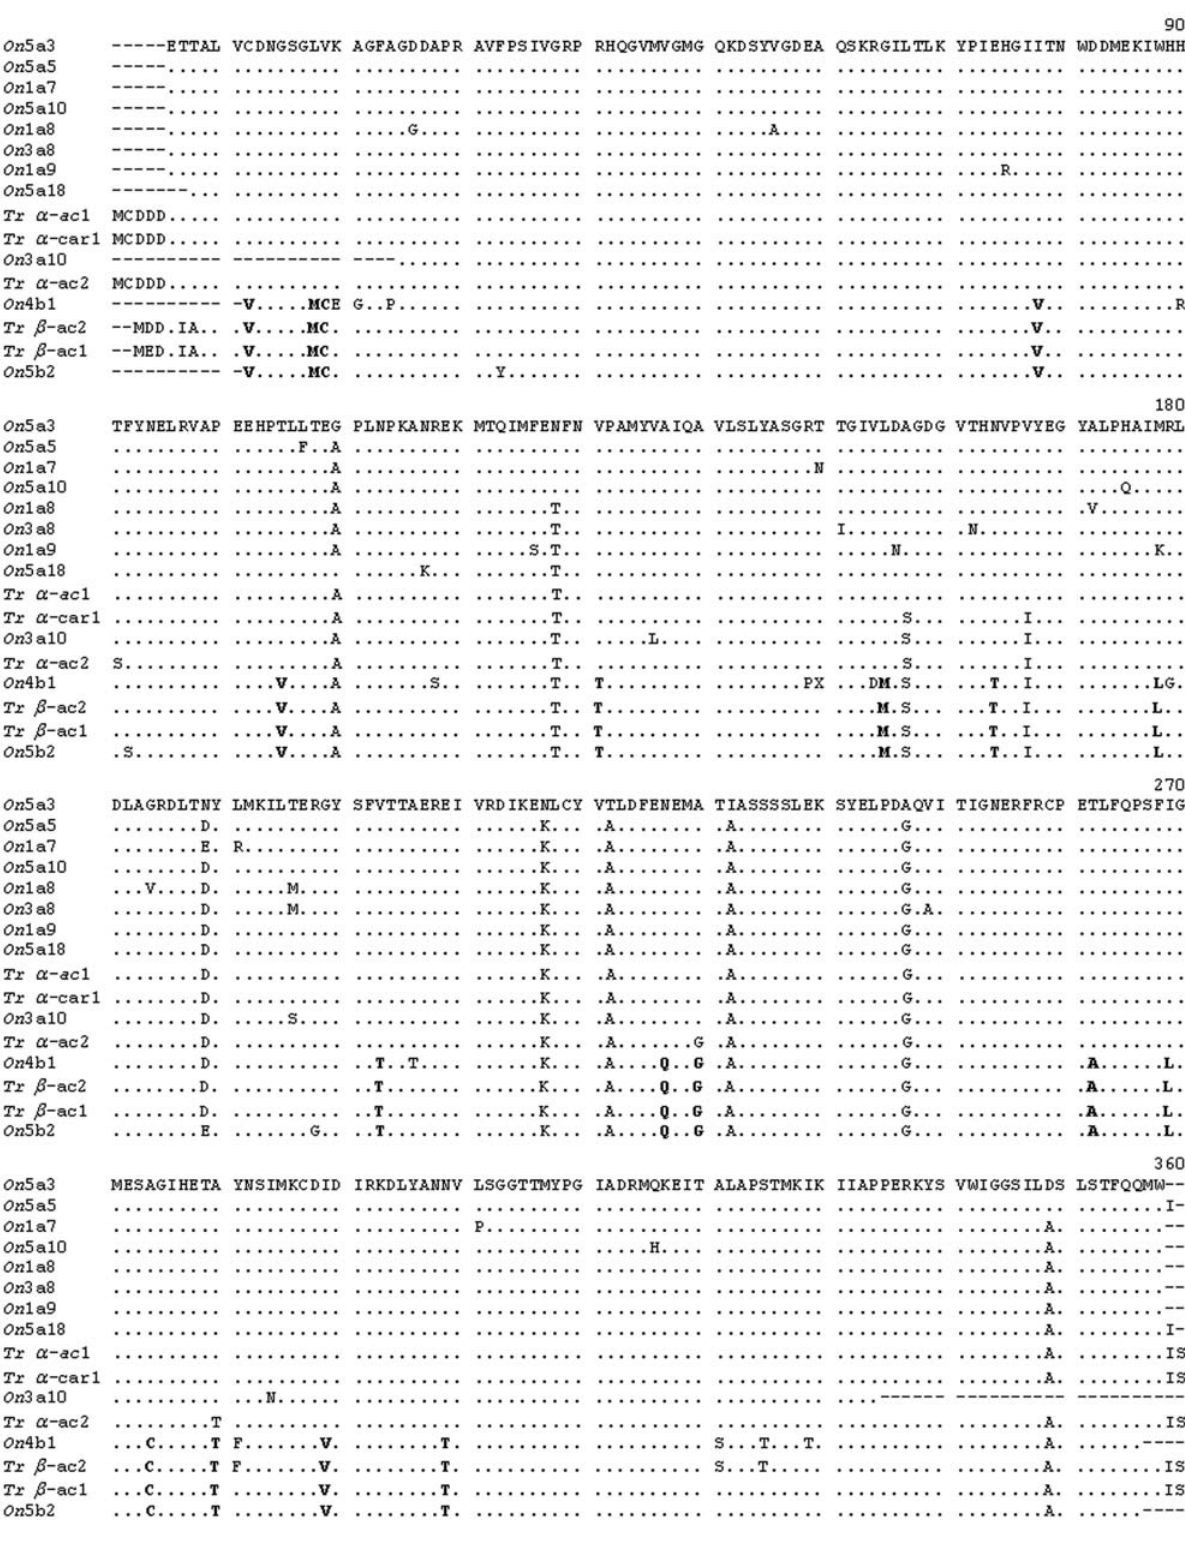
Figure 1 - Alignment of putative amino acid sequences of actin cDNAs isolated from Oreochromis niloticus ( On ) and cDNAs of Takifugu rubripes ( Tr ) obtained from NCBI database. Dashes indicate gaps introduced in the sequences to optimize the alignment. Diagnostic aa positions that distinguish α -muscle actin from β -cytoplasmic actins are in bold face type. Sources and accession numbers for the actin sequences are described in Materials and